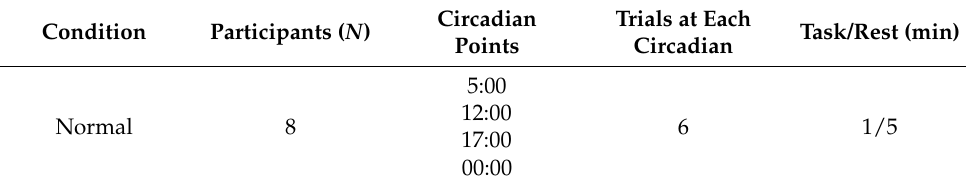
Table 1. Data collection for Experiment 1: eight participants, four circadian points, six trials at each circadian